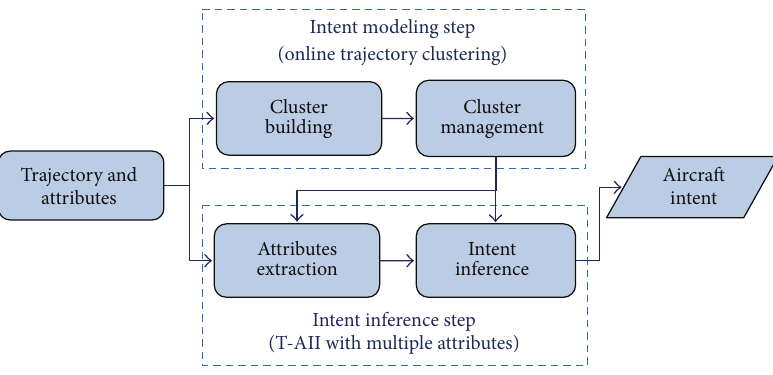
Figure 2: Block diagram of the proposed T-AII